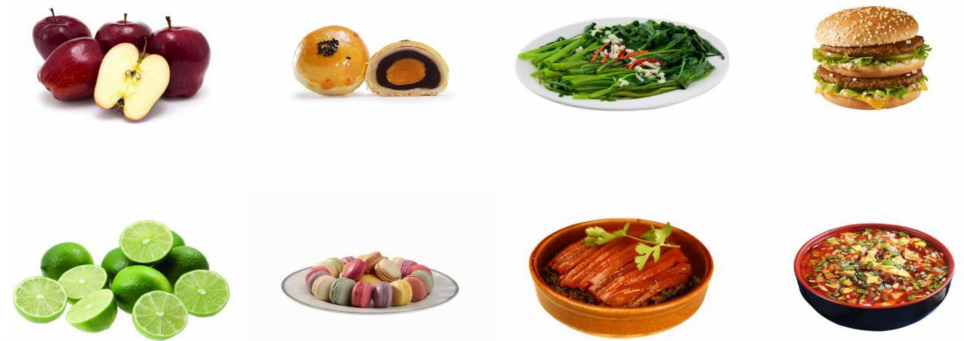
Figure 2. Samples of Chinese food images. The images are sourced from open-source photo